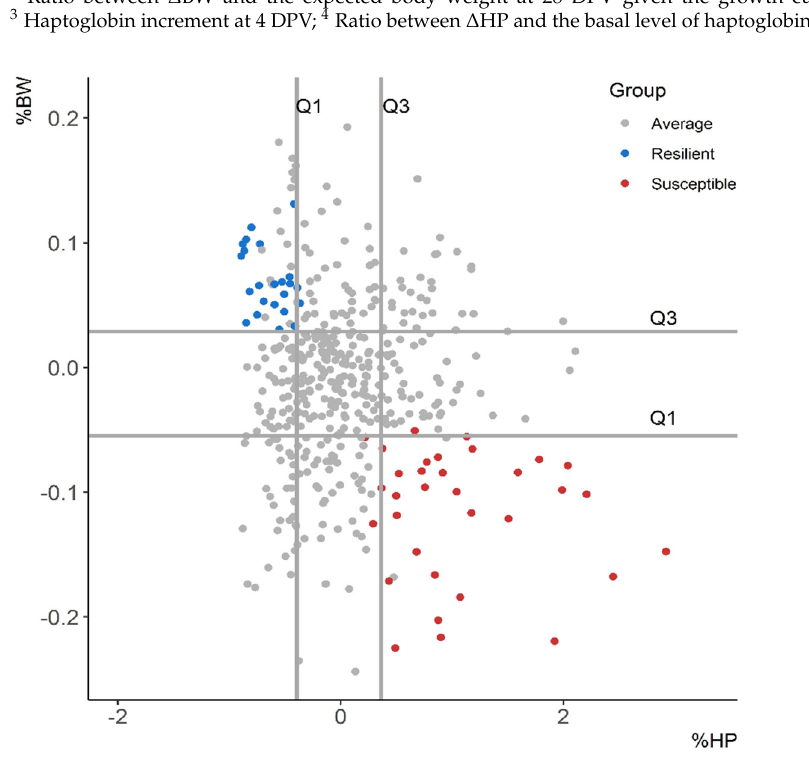
and third (Q 3 ) quartiles of ∆ BW and ∆ HP on the plane defined by %HP and %BW. Individuals were